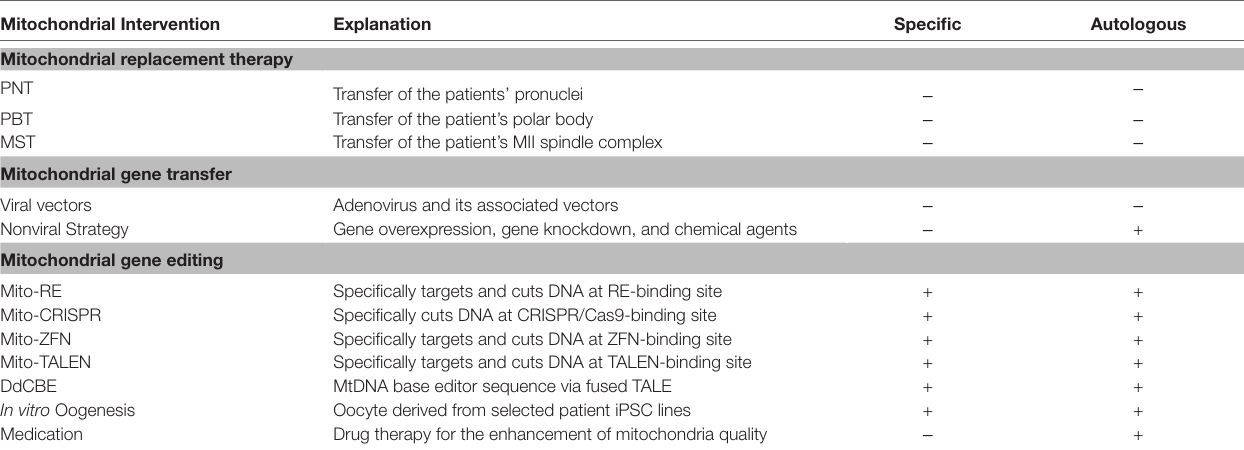
TABLE 1 | Comparison of different mitochondrial